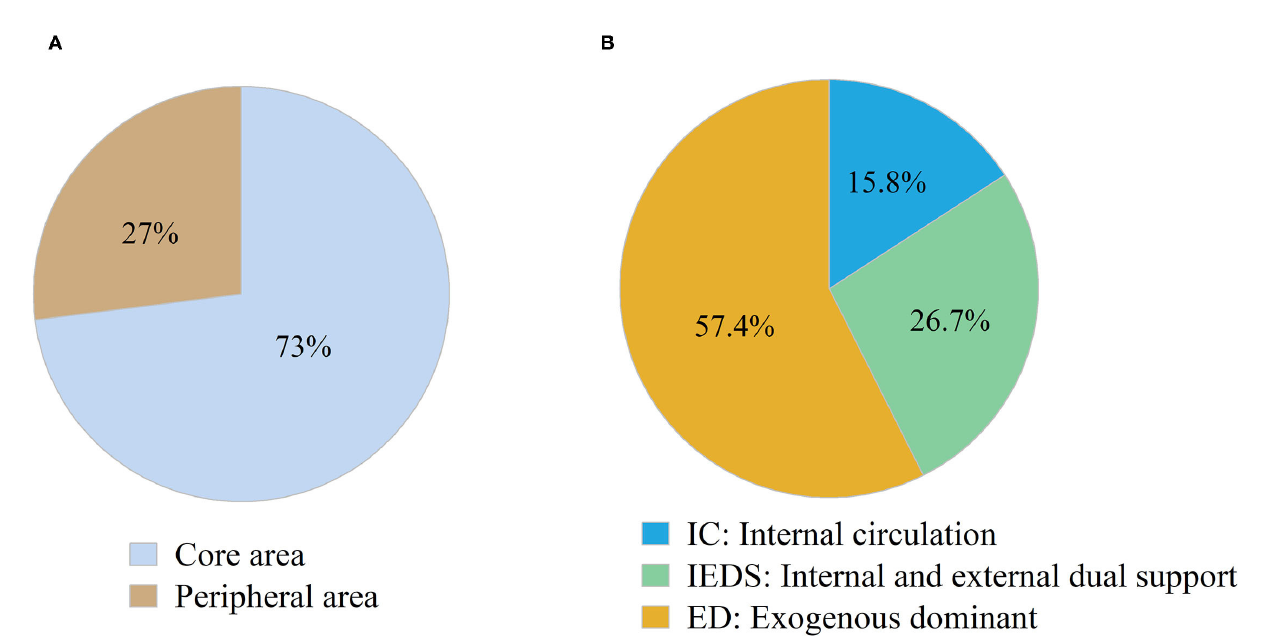
FIGURE3 Results of household classification using two standards: (A) the weight of the core and peripheral areas in the spatial classification; (B) the weight of each of the three farmer types.